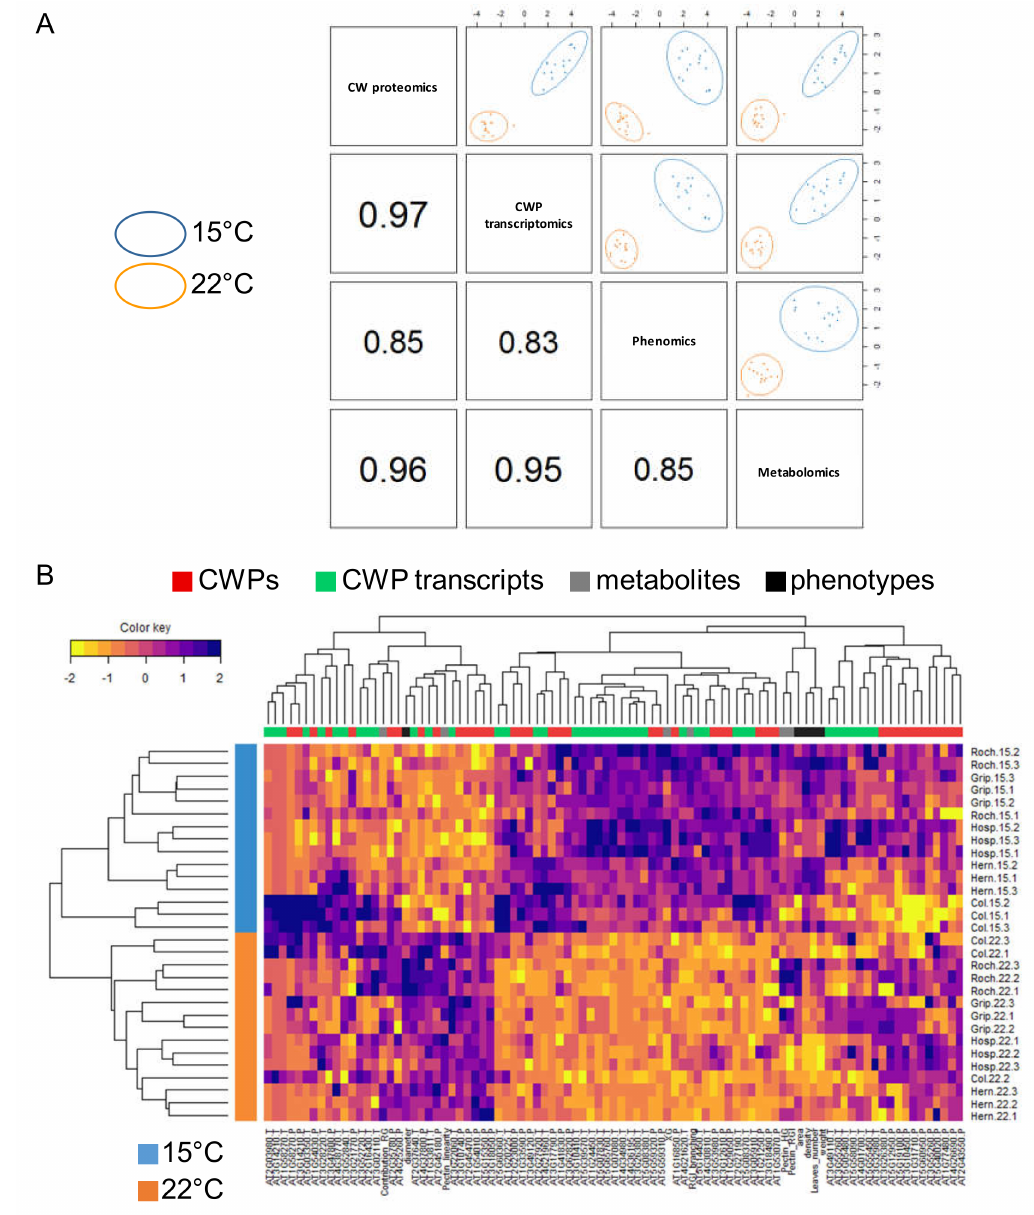
Figure 6. Graphical representation of the sparse multi-block partial least squares discriminant analysis (MB-PLS-DA) analysis discriminating the rosette samples of Col, Roch, Grip, Hern and Hosp according to the growth temperature. ( A ) The plotDIABLO shows the correlation inside each block pair; ( B ) clustered image map representing the multi-omics profiles for each sample discriminated by the growth temperature. The levels of yellow (lower values) and purple (higher values) denote scaled values for each variable. Note that colors are scaled per